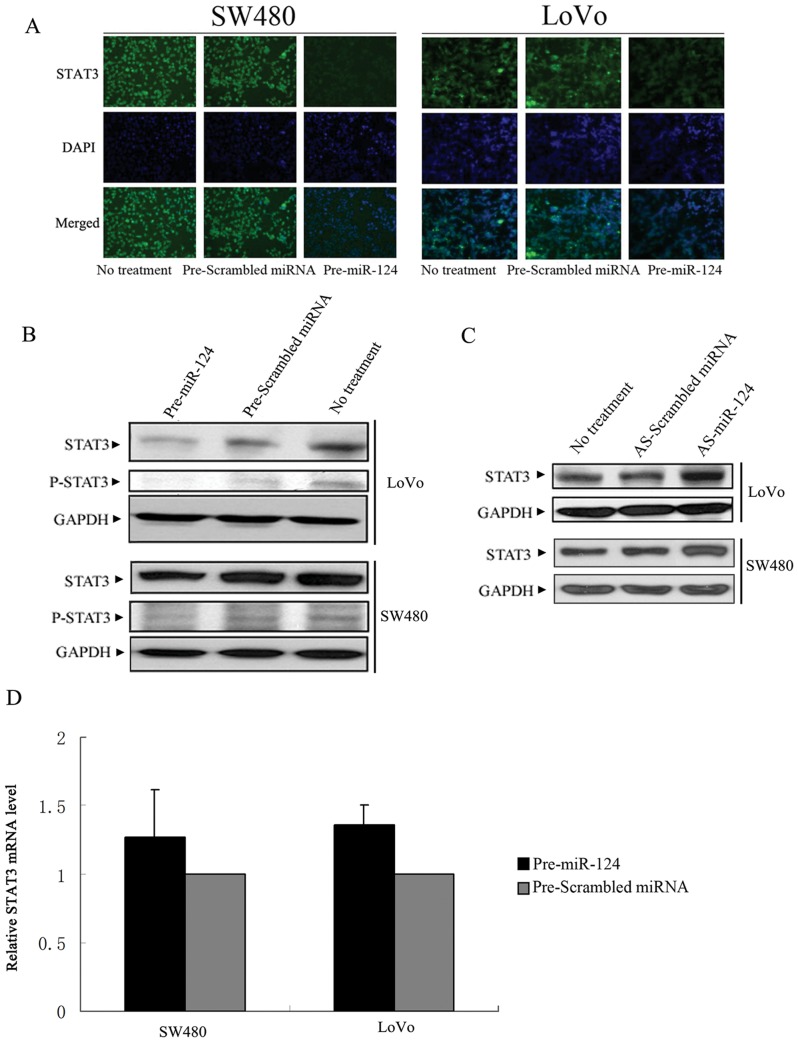
MiR-124 suppresses the expression of STAT3 in human CRC cells.(A–B) Effect of miR-124 overexpression on endogenous STAT3 level in human CRC cells. (A) SW480 and LoVo cells were transfected with Pre-miR-124 and stained for STAT3 by immunofluorescence analysis. Green, STAT3 protein was immunostained with anti-STAT3; blue, nuclei were stained with DAPI. (B) SW480 and LoVo cells were transfected with Pre-miR-124 and STAT3 protein levels were examined by Western blotting analysis. (C) SW480 and LoVo cells were transfected with AS-miR-124. STAT3 protein levels were examined by Western blotting. (D) The levels of STAT3 mRNA were quantified by qRT-PCR analysis after transfection of Pre-miR-124. GAPDH were used as an internal control. Data are represented as mean±SD±SD.